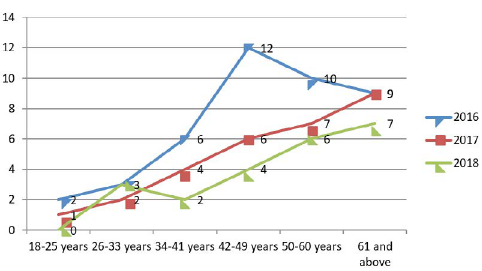
Fig. 1. Age-wise distribution of CA-UTI patients